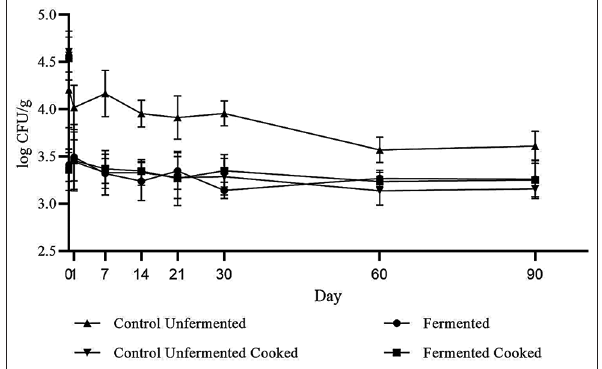
Figure-1: Viability of Clostridioides difficile spores in fermented pork